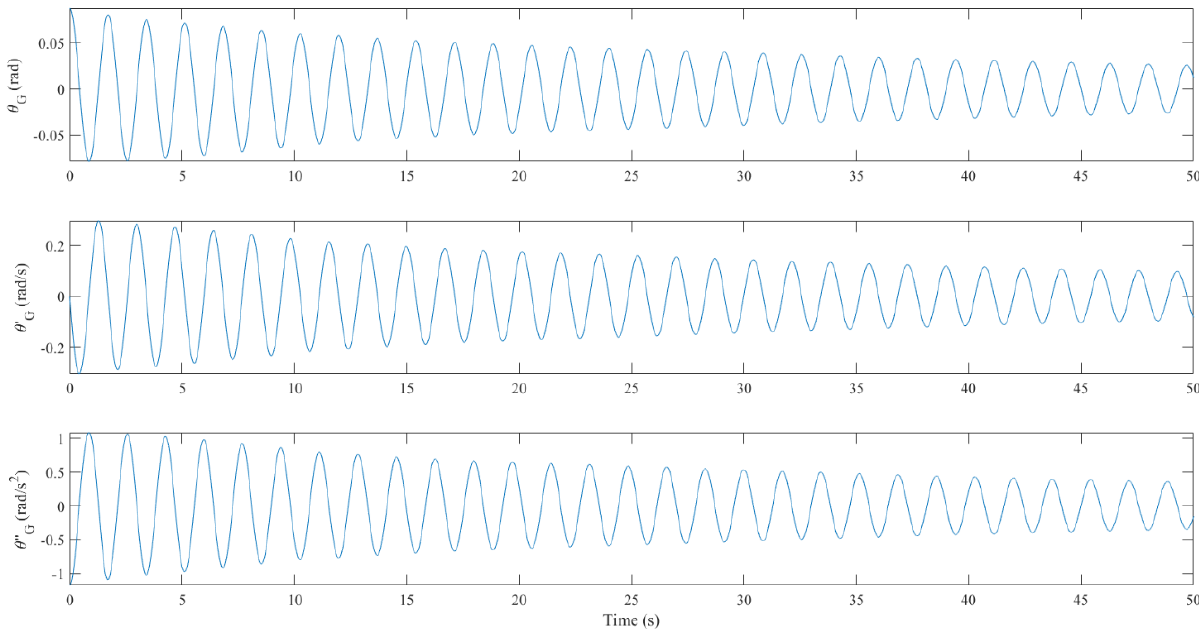
Figure 5. The angular displacement, velocity, and acceleration time histories of the floating body under free vibration at an initial 5° pitch.